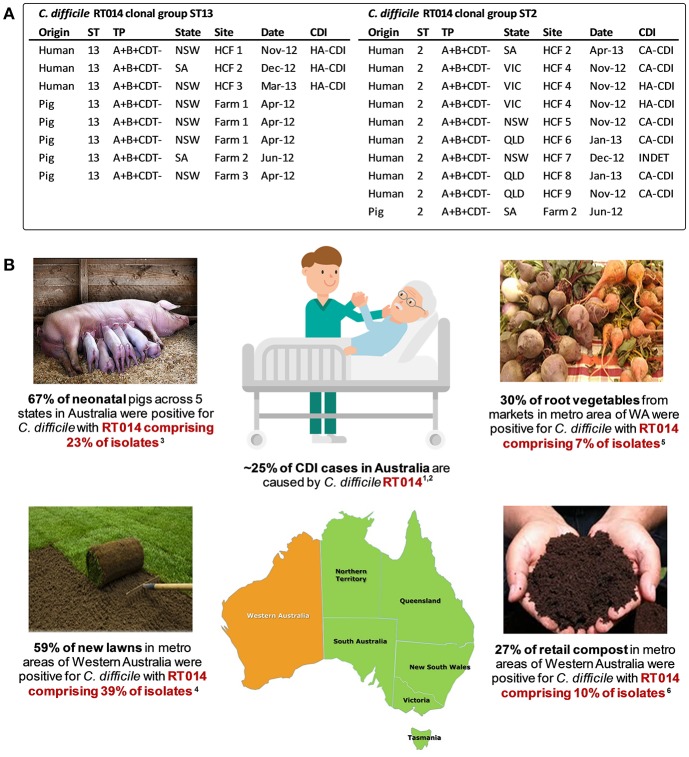
Transmission networks and community reservoirs of C. difficile RT014 in Australia. (A) summary of ST13 (n = 8) and ST2 (n = 10) RT014 clonal groups found in pigs and humans with CDI in Australia, adapted from Knight et al. (128). A clonal group is defined as two or more strains differing by <2 SNVs in their core genome. HCF, healthcare facility; NSW, New South Wales; SA, South Australia; VIC, Victoria; QLD, Queensland; INDET, indeterminate. (B) summary of RT014 ecological niches in Australia. 1Knight et al. (186); 2Collins et al. (188); 3Knight et al. (52); 4Moono et al. (151); 5Lim et al. (84); 6Lim et al. (122).